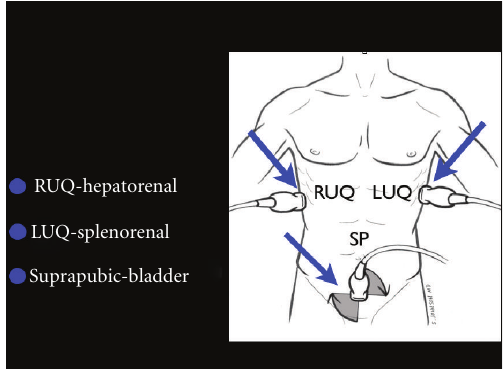
Figure 15: Small, collapsing internal jugular vein, short axis view. IJ: internal jugular vein, CA: carotid artery.